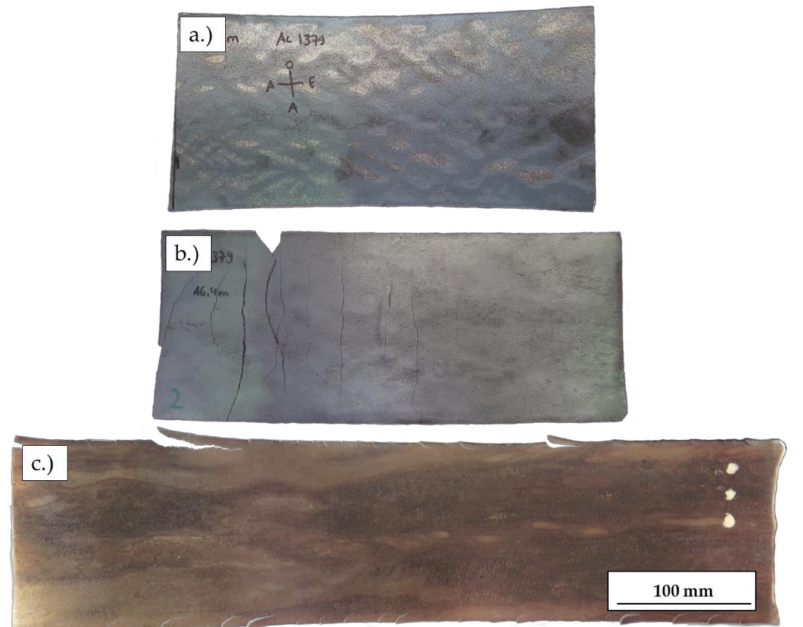
Figure 6. Macroscopic images of the cast and rolled samples of AC1379: ( a ) as cast state; ( b ) cold rolled sample; ( c ) warm rolled sample at 500 ◦